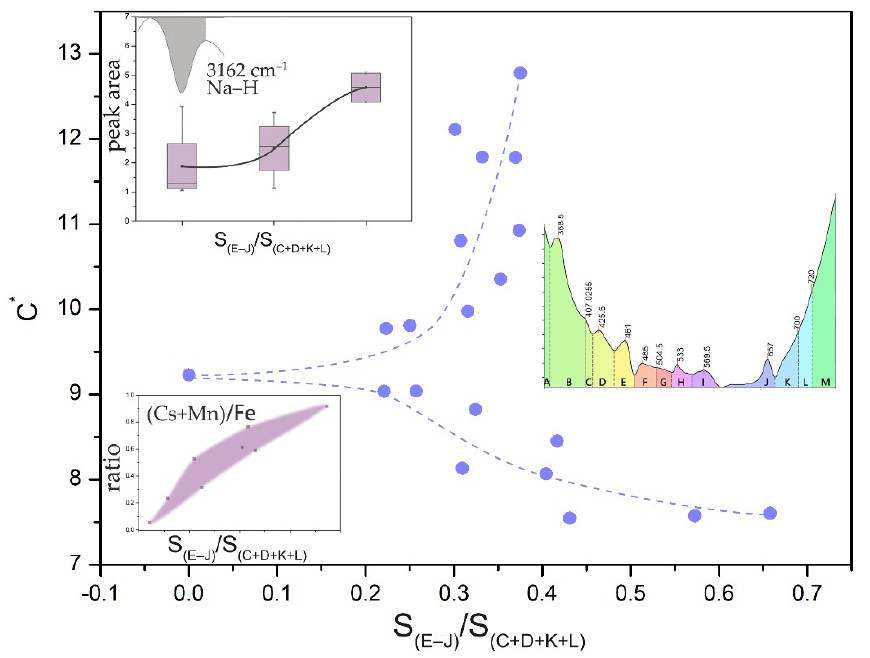
Figure 13. Relationship between S (E-J) /S (C+D+K+L) and C*, including the change in (Cs + Mn)/Fe and the area of peaks at 3161 cm − 1 .